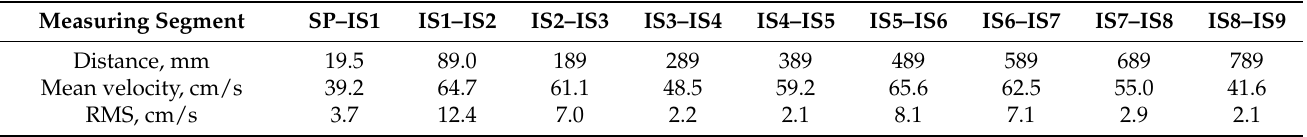
Table 4. Mean flame velocities at measuring segments.